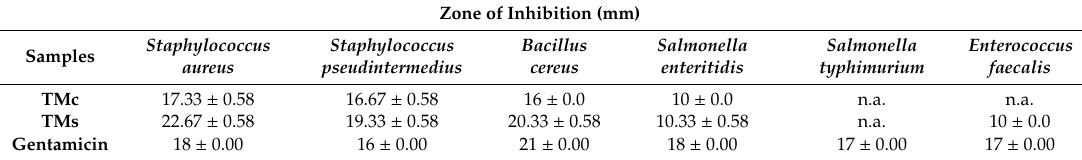
Table 3. Results of the antimicrobial preliminary screening using the well-di ff usion method.